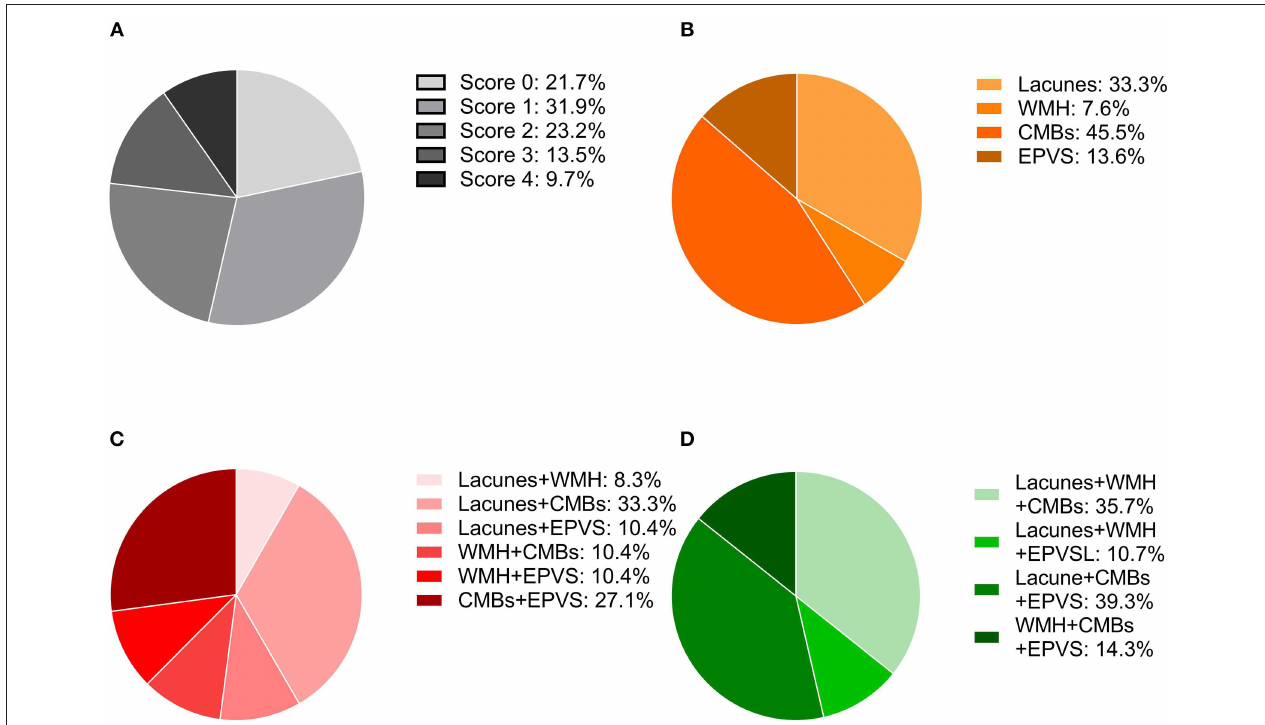
FIGURE 2 | Distribution of the total SVD score and composition of the different scores. (A) Frequency of each score in the whole cohort. (B) Percentage of each lesion when the SVD score was one. (C) Percentages of the combinations of two lesions when the SVD score was two. (D) Percentages of the combinations of three lesions when the SVD score was